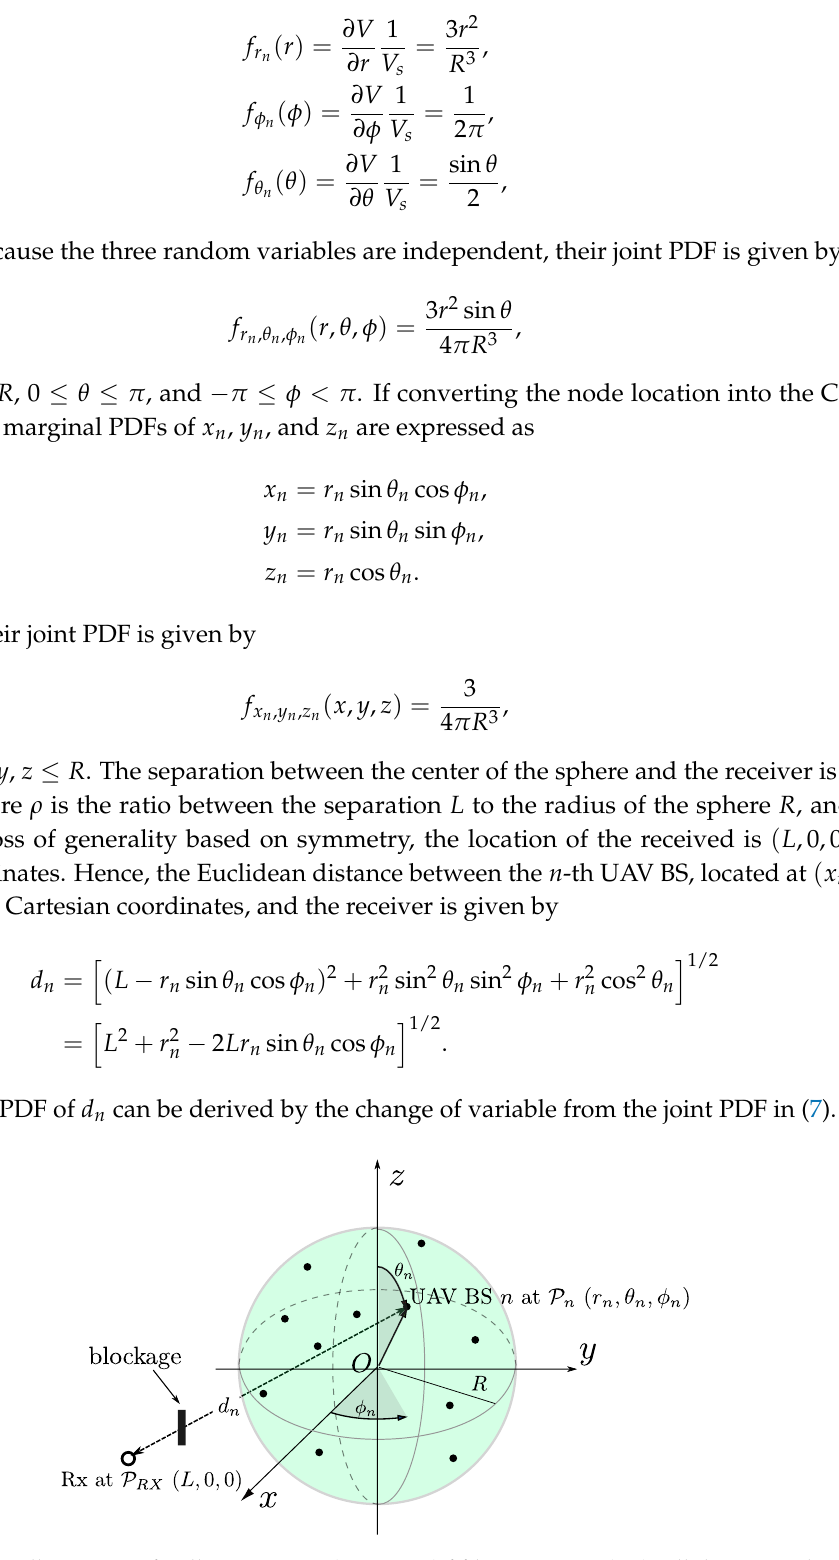
Figure 1. Illustration of millimeter wave (mmWave) fifth-generation (5G) cellular